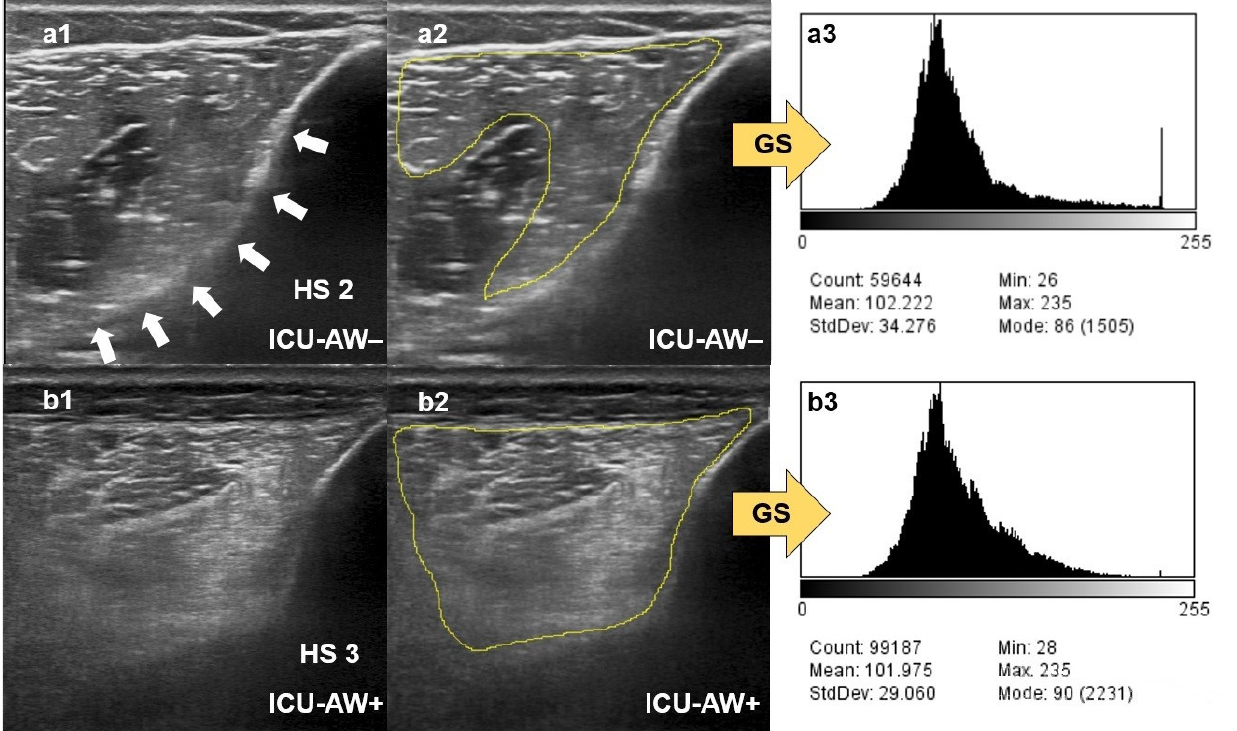
Figure 6. Differences in assessment of muscle echogenicity. ( a1 ) Qualitative assessment of muscle echogenicity of the tibialis anterior muscle of an ICU-AW − patient with increased muscle echo inten- sity, but nearly fully visible cortical bone echo signal (white arrows), rated with the Heckmatt scale (HS). ( a2 ) Quantitative assessment of muscle echogenicity of the same muscle depicted in a1 using ImageJ by selecting a region of interest (yellow marked; the acoustic shadow image artifact behind the central tibialis anterior aponeurosis has been excluded) within the affected muscle and consecu- tive greyscale analysis (GS) with the corresponding histogram ( a3 ). ( b1 ) Qualitative assessment of muscle echogenicity of the tibialis anterior muscle of an ICU-AW+ patient with increased muscle echo intensity and nearly vanished cortical bone echo signal, rated HS 3. ( b2 ) Quantitative assessment of muscle echogenicity of the same muscle depicted in b1 using ImageJ by selecting a region of interest (yellow marked) within the affected muscle and consecutive GS with the corresponding histogram in ( b3 ). The mean GS values of the quantitative assessments ( a3 , b3 ) are almost equal, so patients with ICU-AW cannot be distinguished from patients without ICU-AW. In contrast, in the qualitative assessments ( a1 , b1 ) using the HS, a clear difference in the visibility of the tibialis cortical bone echo signal between ICU-AW+ and ICU-AW- patients can be